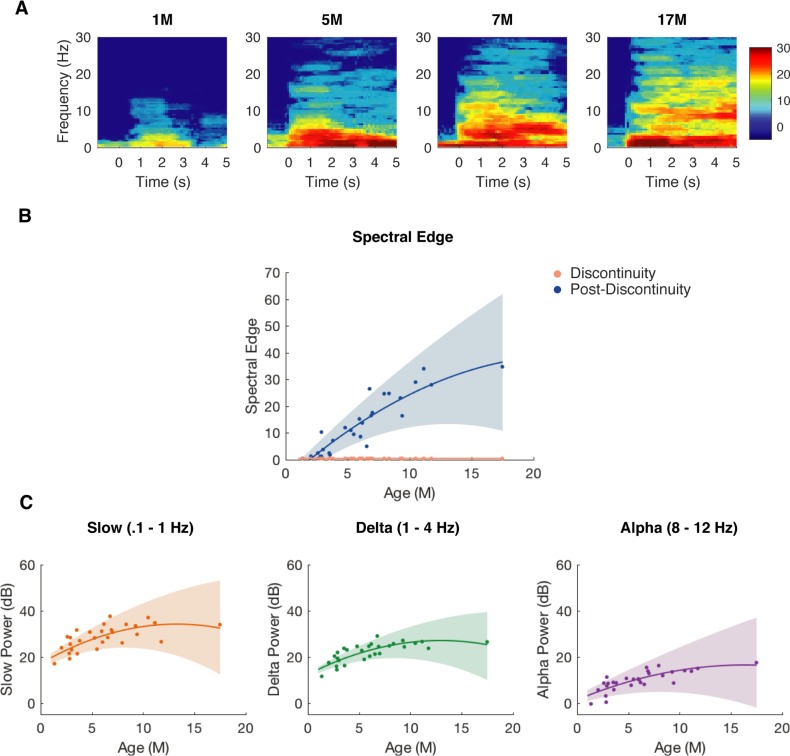
Power spectra of discontinuous activity varies with age.(A) Representative spectrograms of burst-like activity following discontinuity in children aged 1-, 5-, 7-, and 17 months-old. (B) Spectral edge of burst-like activity following suppression increases with age (n = 29) and is greater than spectral edge of suppression in children > 3-months-old. (C) Slow (.1–1 Hz), Delta (1–4 Hz), and Alpha (8–12 Hz) power all increase with age (n = 29).